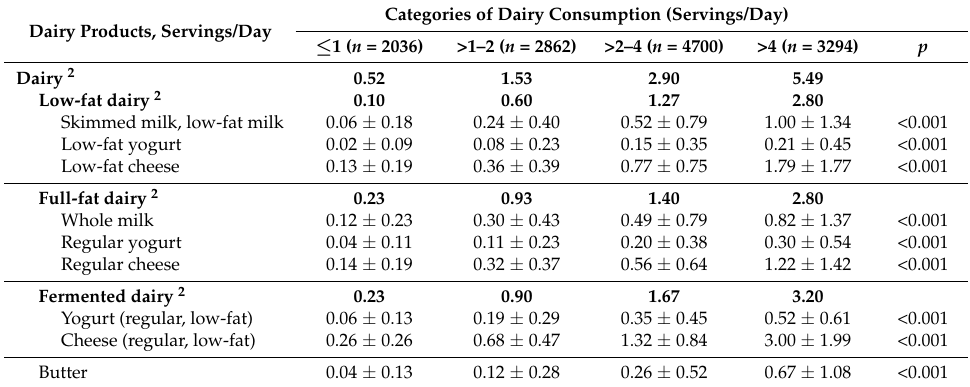
Table 1. Intake of dairy products according to categories of total dairy intake. ELSA-Brasil, 2008–2010 1 .